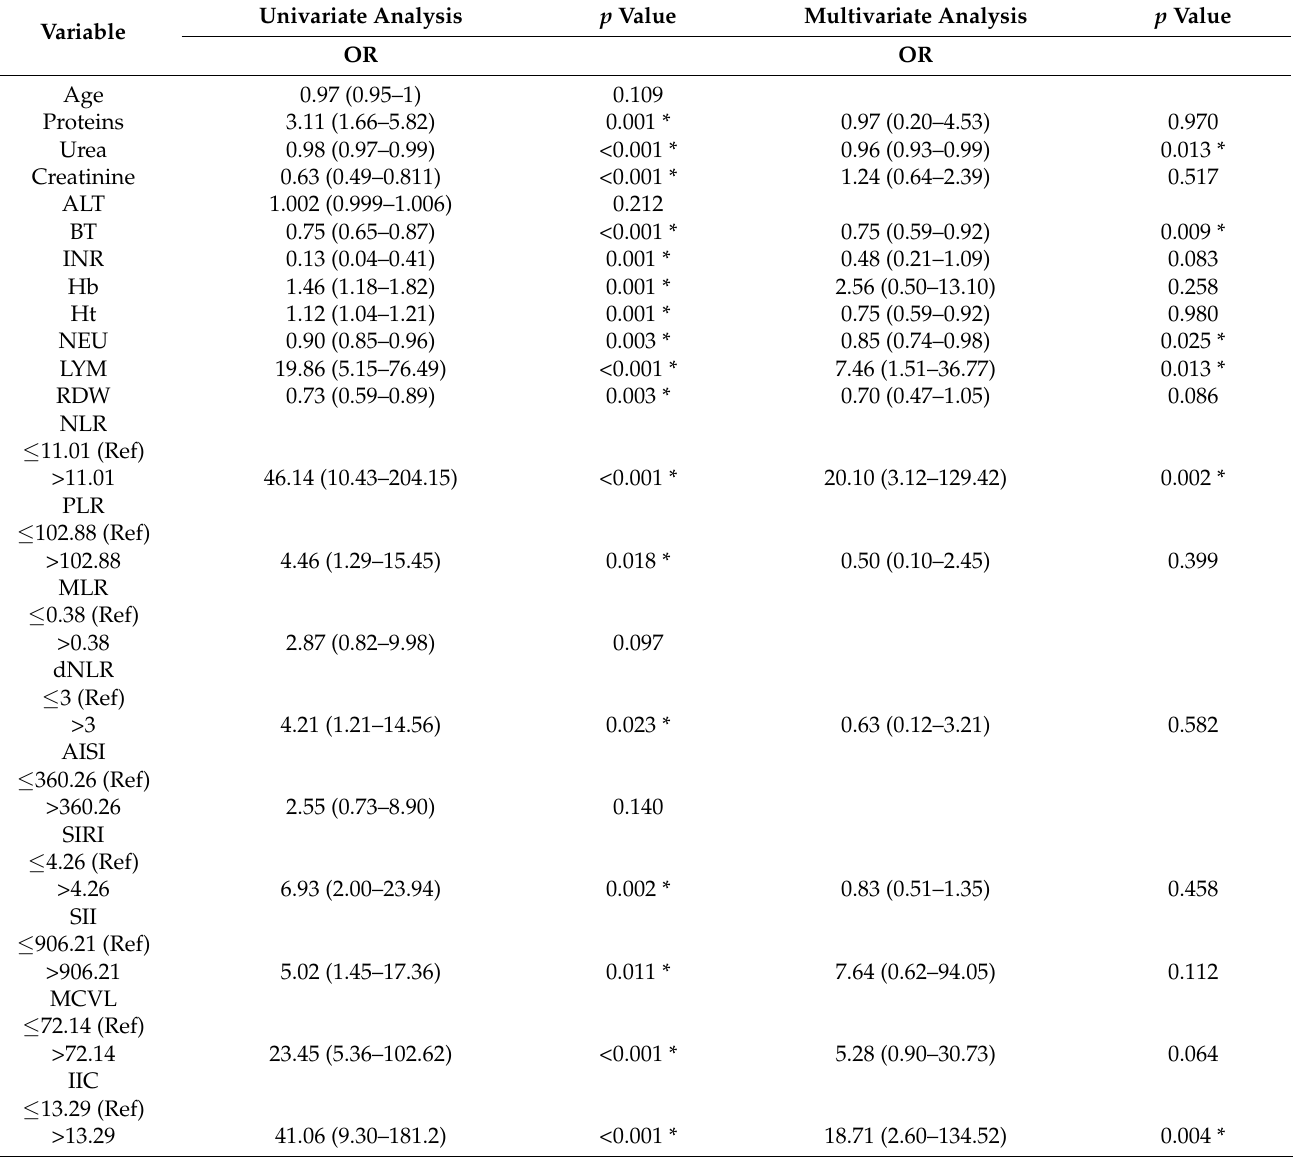
Table 11. Univariate and multivariate analyses of variables associated with mortality in pre-COVID